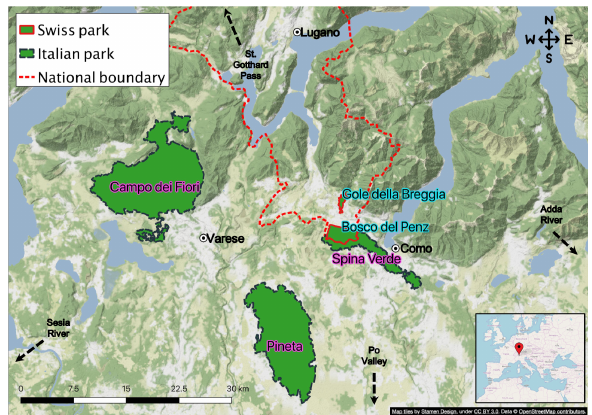
Figure 1. Project area and the natural parks involved in the INSUBRIPARKS project